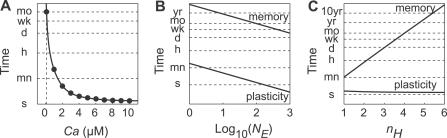
Temporal Properties(A) The time constant of f, τf, as a function of Ca in the deterministic (line) and stochastic models (circles, n = 20). Dashed line: Ca
0.(B) Time constants for plasticity and memory (see Methods) versus the number of enzyme molecules, NE.(C) Time constants versus the Hill number for Ca activation nH..In (B) and (C), all other parameters are kept at their standard value in the deterministic model (see Methods).